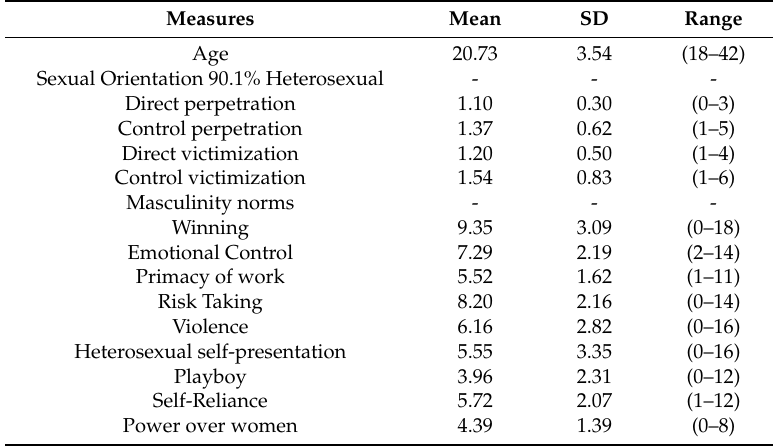
Table 1. Summary statistics of the study